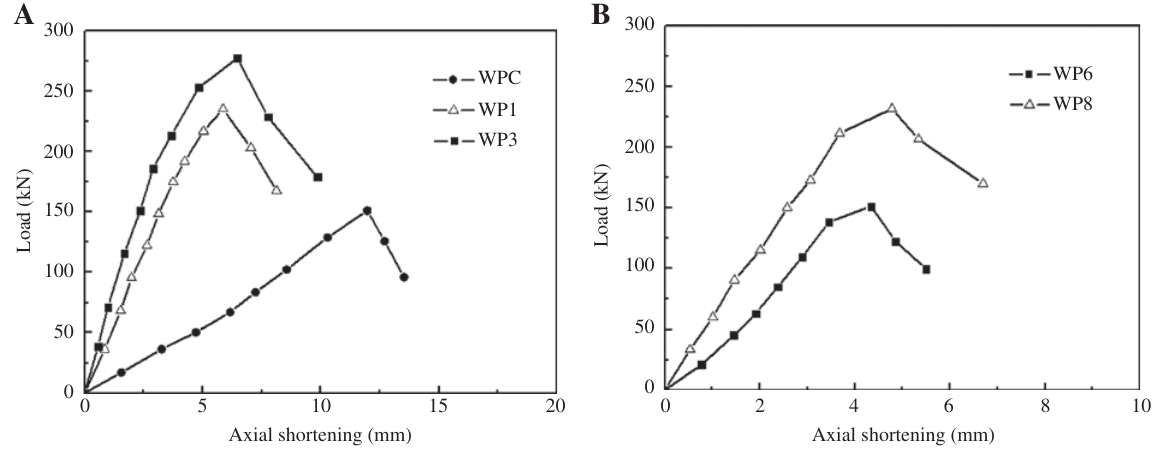
= 1000 mm, t = 2.4 mm and (B) h = 50 mm, l e s